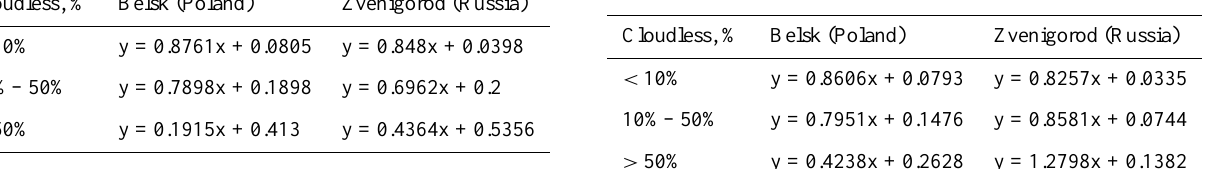
Table 2. Coefficients of the linear regression between the AERONET data and the retrieved AOT values with additional dis- crimination of pixels adjacent to the cloudy